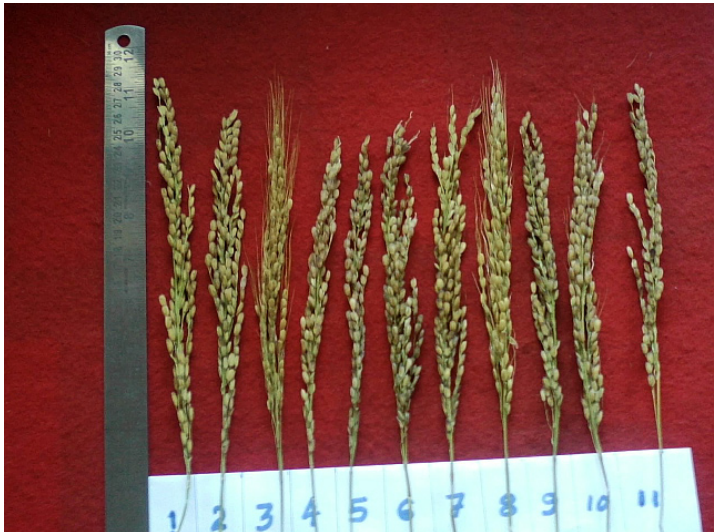
Fig. 2. Genetic variability for panicle length and other panicle traits in differ- ent red rice ecotypes from temperate region of Kashmir,